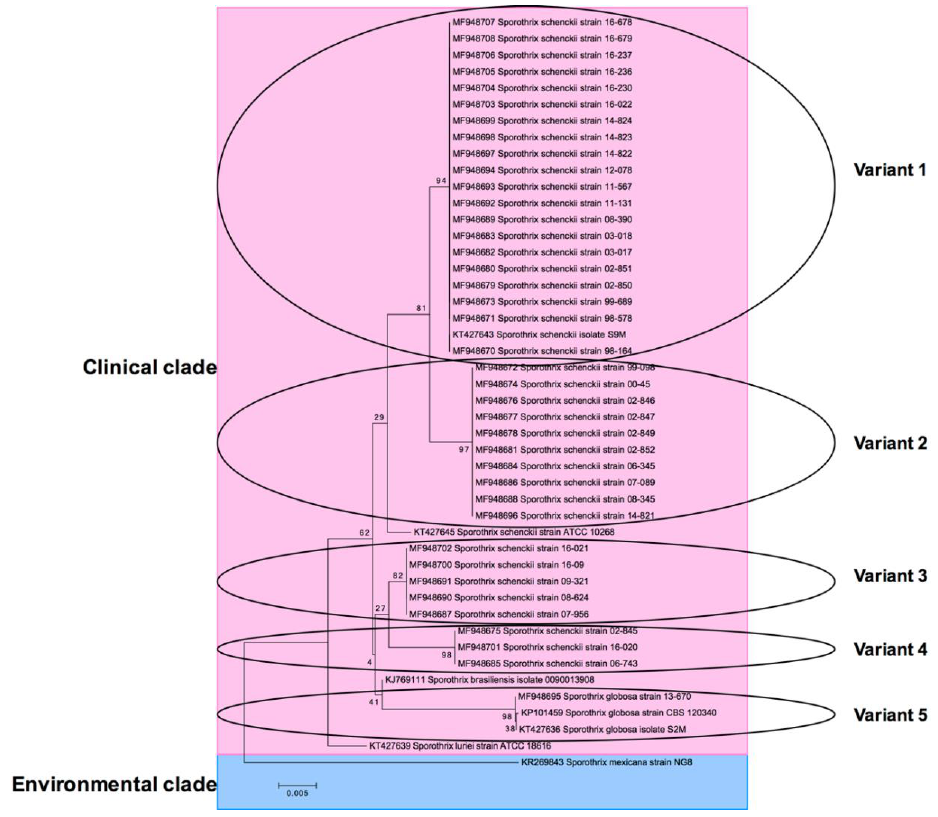
Figure 3. Phylogenetic tree of the CAL coding sequences from various fungi. The tree was built using MEGA version 6.06 by the neighbor-joining (NJ) method and further bootstrap analysis of 1000 replicas. Number on the branches indicate the bootstrap value. From the top to the bottom, clades are in linage-specific manner. Pink encompasses the clinical species, while blue is the environmental specie that was used as the out-group. Clinical clade was further divided into small subclades or variants (ovals) that correspond to the specific Sporothrix specie. Subclades did not match with geographical origin or antifungal resistance.